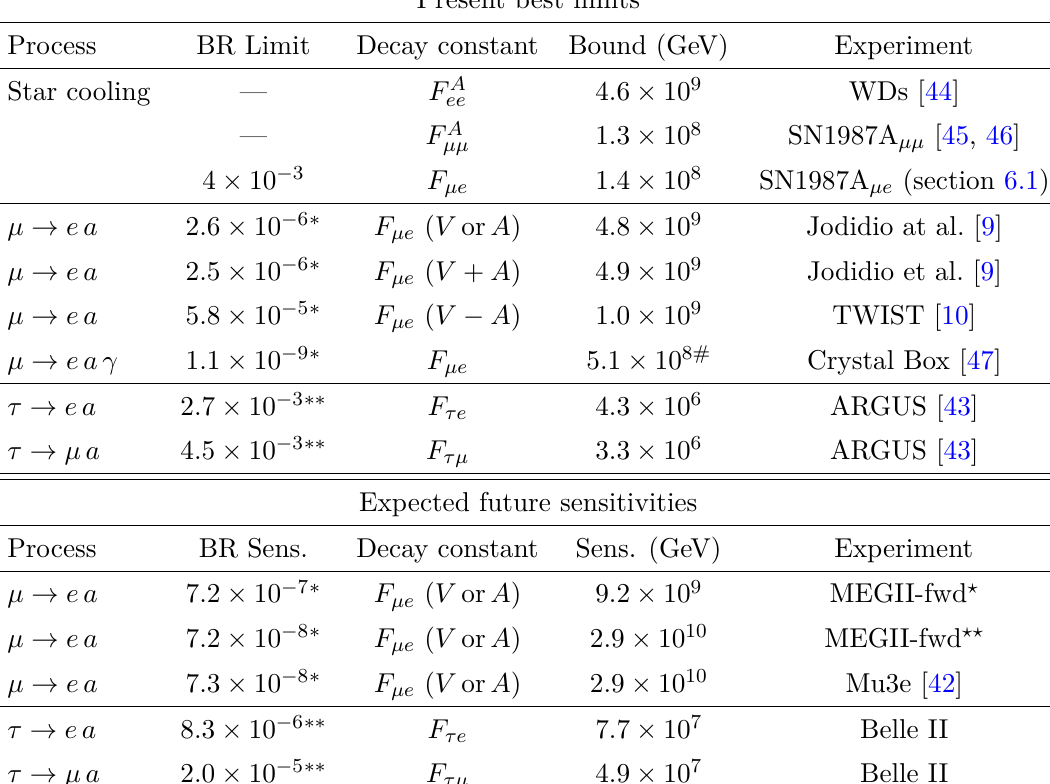
Table 1 . The present model independent 95% C.L. best bounds on leptonic ALP couplings F V,A